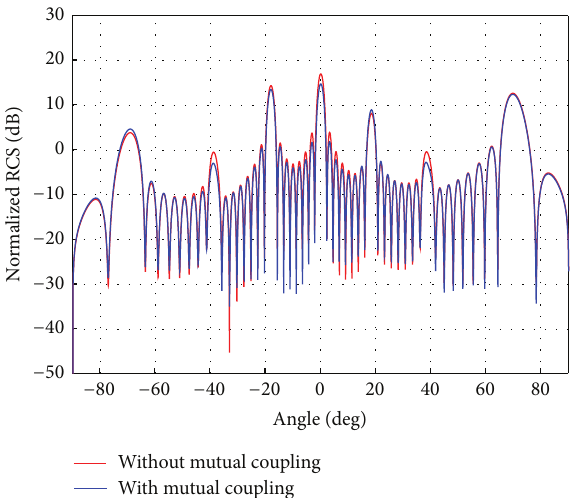
Figure18:ScannedRCSofaparallel-fedcollinear32-elementdipole array ( 𝜃 𝑠 = 70 ∘ ), due to the scattering at first-level couplers only.